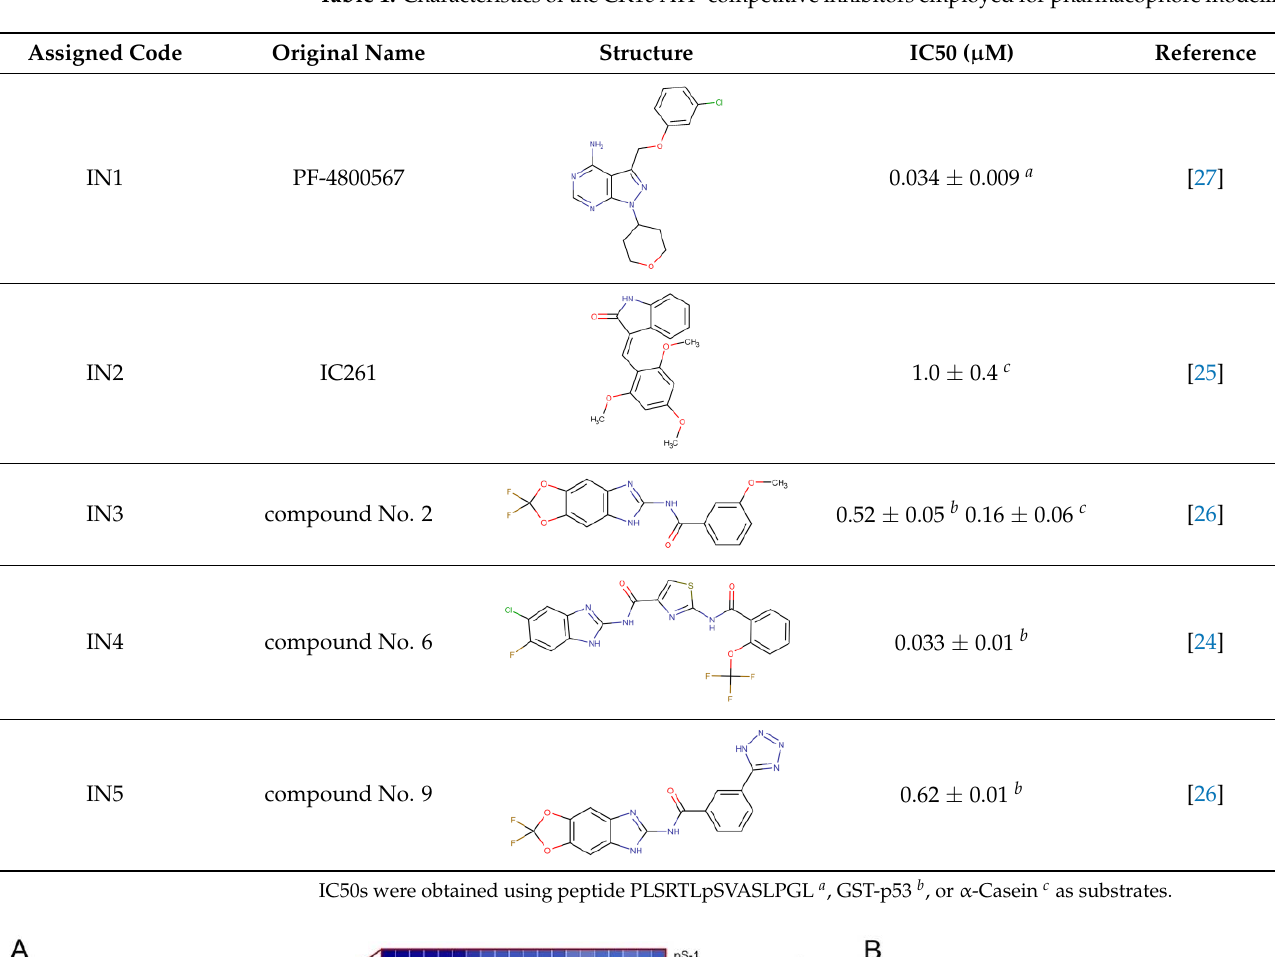
Table 1. Characteristics of the CK1ε ATP-competitive inhibitors employed for pharmacophore modeling.